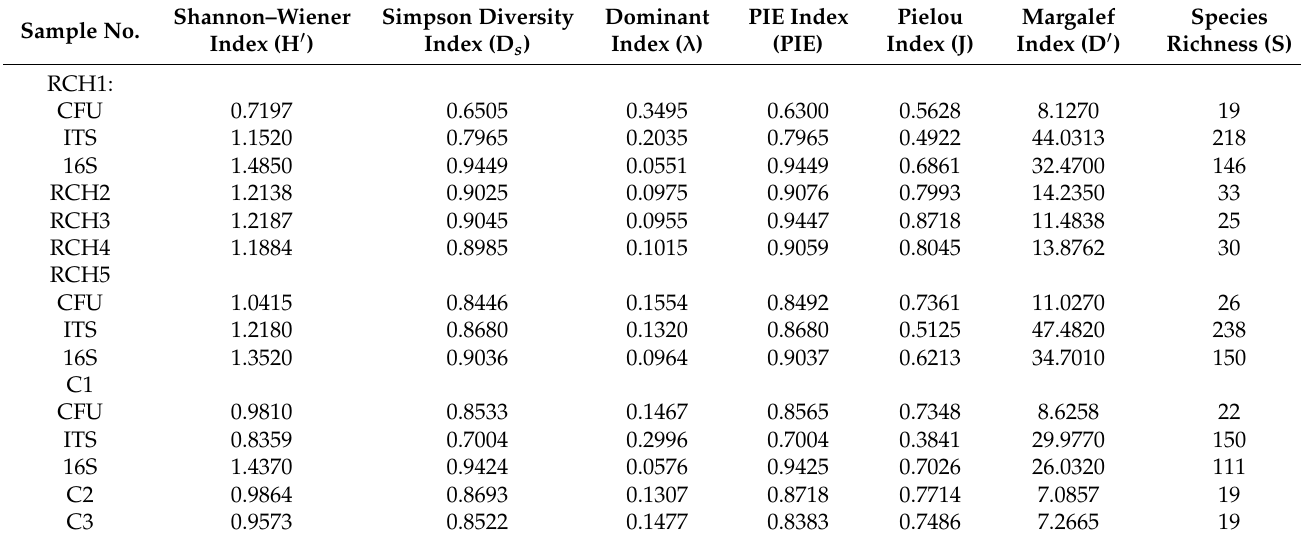
Table 8. Microbial diversity analysis based on culturable fungi and ITS and16S rDNA next generation sequencing from relict charcoal hearths (RCH) soil and control